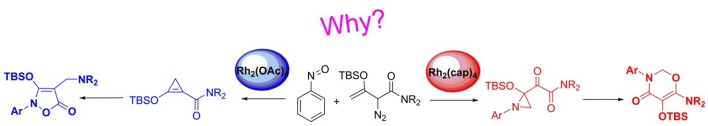
GRAPHICAL ABSTRACT Catalyst-dependent chemoselectivity.